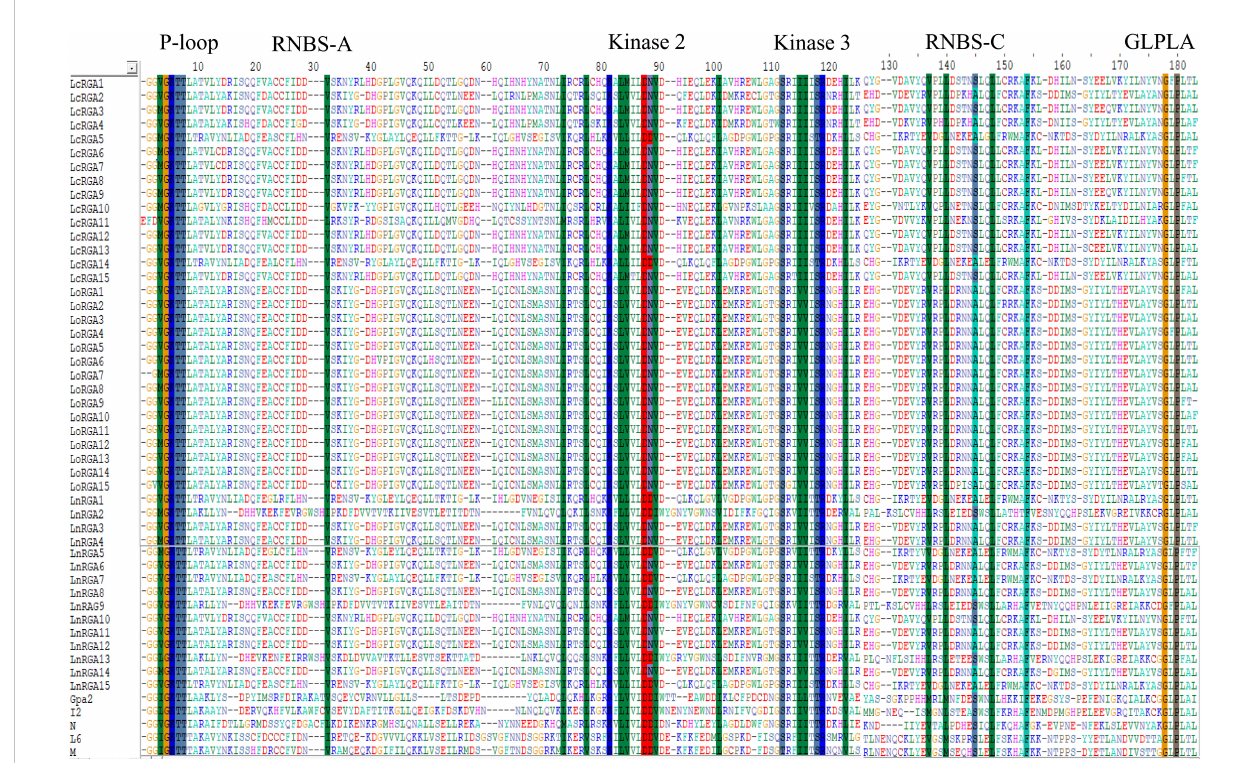
FIGURE 5 Multiple sequence alignment between P-loop and GLPLA of 45 lentil RGAs with NBS region of known R gene Gpa2, I2, N, L6, and M. The conserved motifs are indicated above the alignment. The number of amino acids is indicated above the alignment. The gaps to optimize the alignment are designated by dash (-). The alignment was constructed using CLUSTA W of